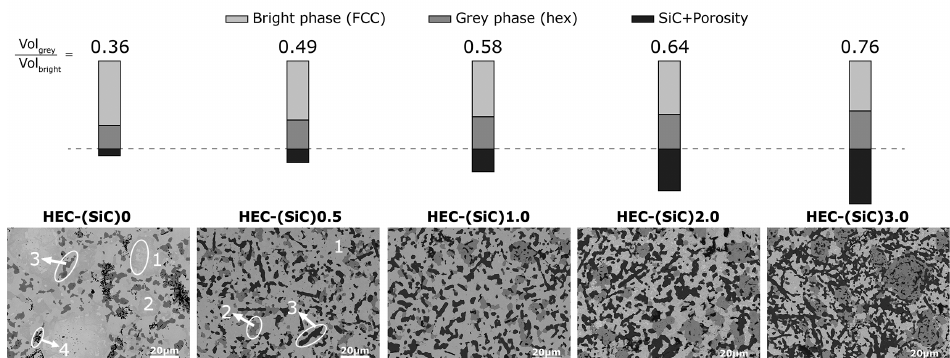
Figure 3. Backscattered electron micrographs of HEC with different SiC content sintered at 2000 °C, the volume fraction ratio between the gray and bright phase shows increased amount of gray phase with increased SiC content.